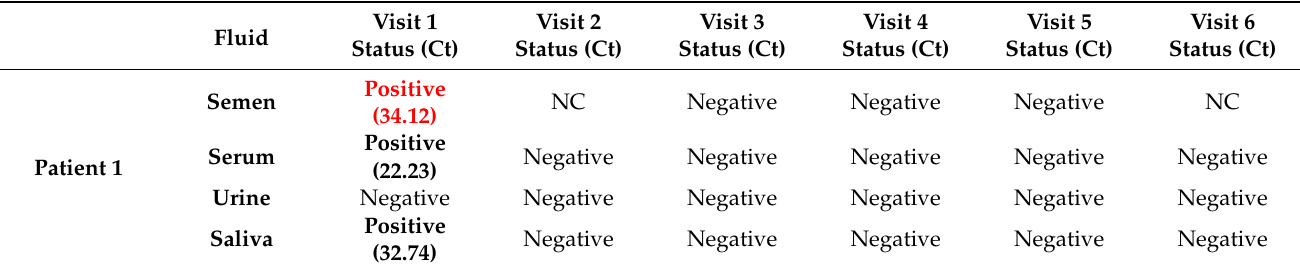
Table 1. Detection of CHIKV RNA in bodily